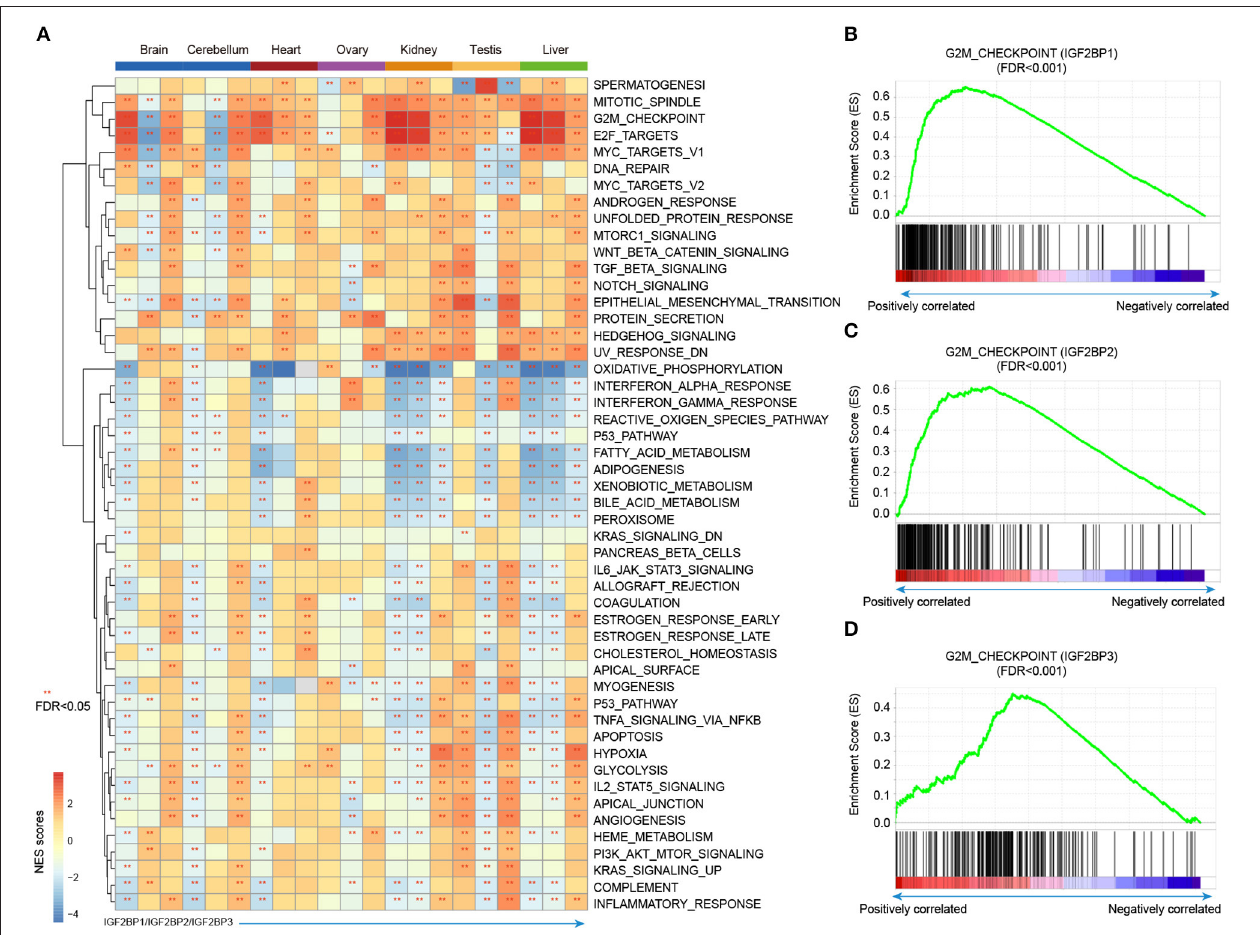
FIGURE 5 | Gene set enrichment analysis of genes correlated with IGF2BPs in different tissues. (A) Heat map showing the normalized enrichment scores of GSEA. Functional pathways with FDR < 0.05 were indicated with red stars. Each row represents one cancer hallmark-related pathway and each three column corresponding to one tissue. The first column is for IGF2BP1, second column is for IGF2BP2, and third column is for IGF2BP3. (B) GSEA plots showing genes correlated with IGF2BP1 in kidney development enriched in G2M checkpoint pathway. (C) GSEA plots showing genes correlated with IGF2BP2 in kidney development enriched in G2M checkpoint pathway. (D) GSEA plots showing genes correlated with IGF2BP3 in kidney development enriched in G2M checkpoint pathway. ** p < 0.05 for